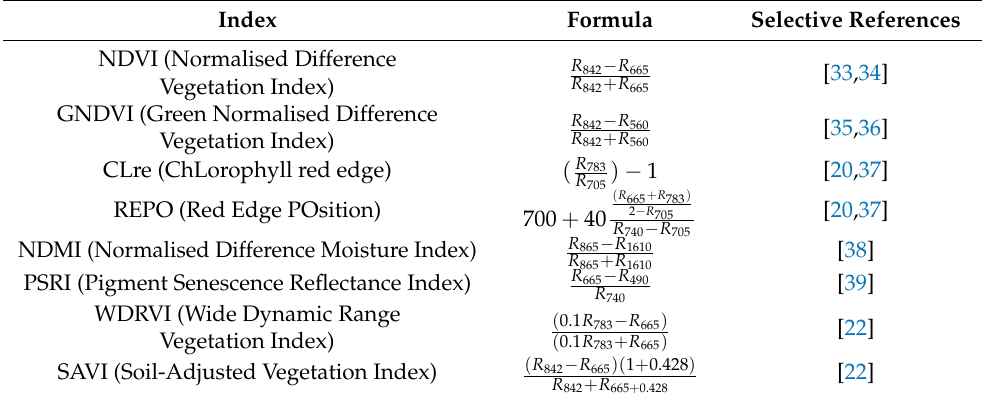
Table 2. Vegetation indices suggested in the literature for vegetation quantity or quality that can be calculated using pairs of Sentinel-2 bands. R i refers to the reflectance factor at wavelength i